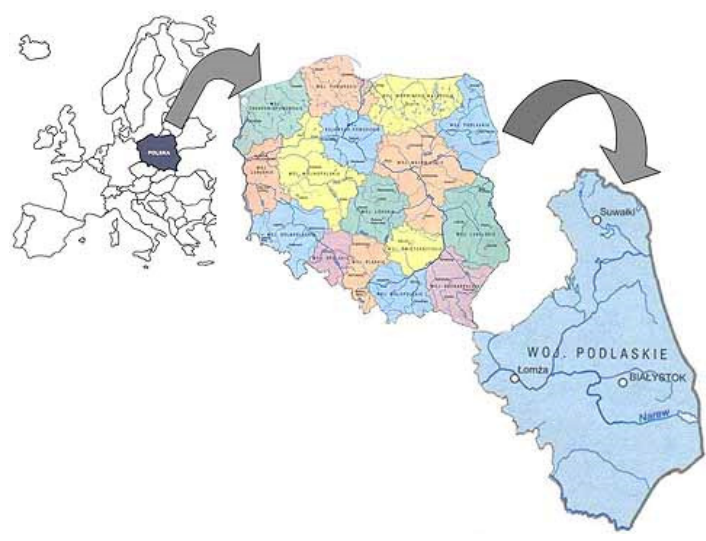
Figure 3. Podlaskie voivodship [53].